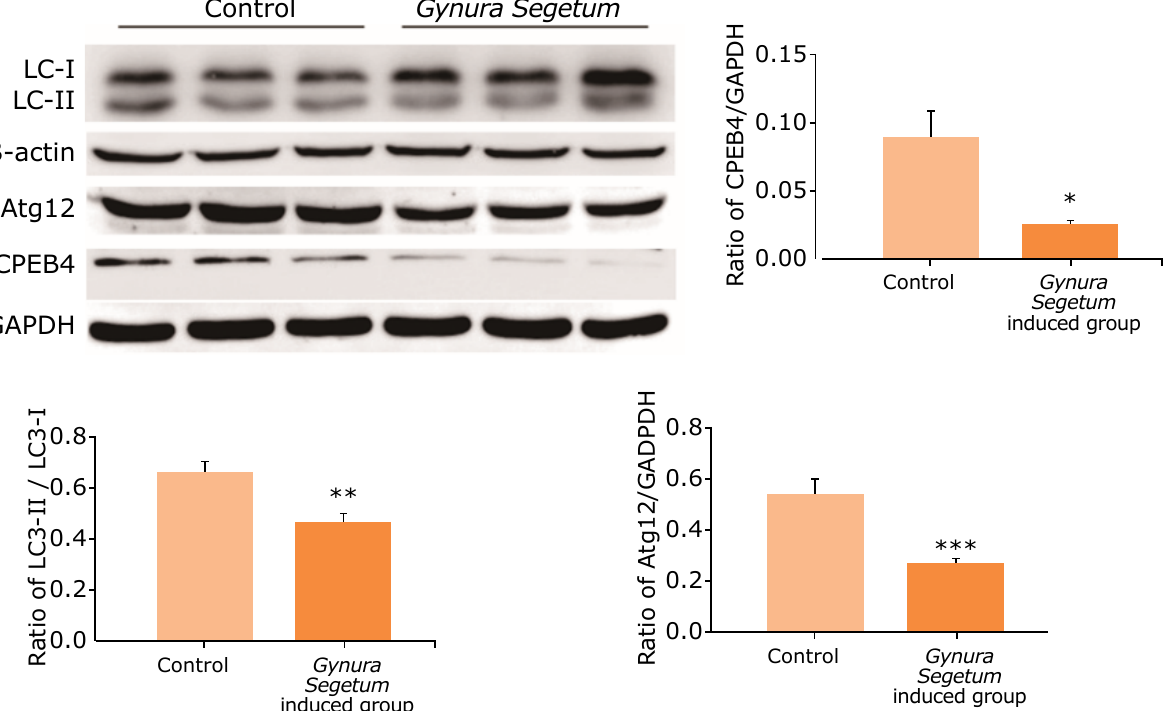
CPEB4: cytoplasmic polyadenylation element binding protein; GAPDH: glyceraldehyde 3-phosphate dehydrogenase; *P < 0.05, **P < 0.01, *** P < 0.001 vs . control group. Figure 7 - Gynura segetum induced hepatic autophagy-related protein expressions in mice (n = 10). Liver tissues were collected at five weeks after Gynura segetum administration, and protein expressions (LC3, Atg12 and CPEB4) were analyzed by Western